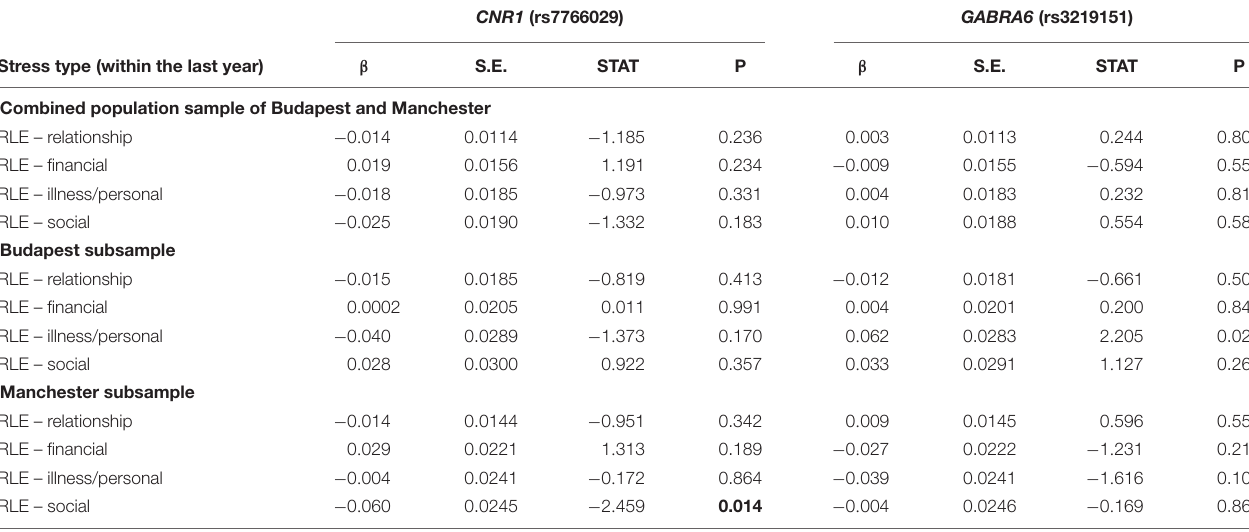
TABLE 2 | Gene-environment correlation between CNR1 (rs7766029) and GABRA6 (rs3219151) polymorphisms and different types of recent negative life